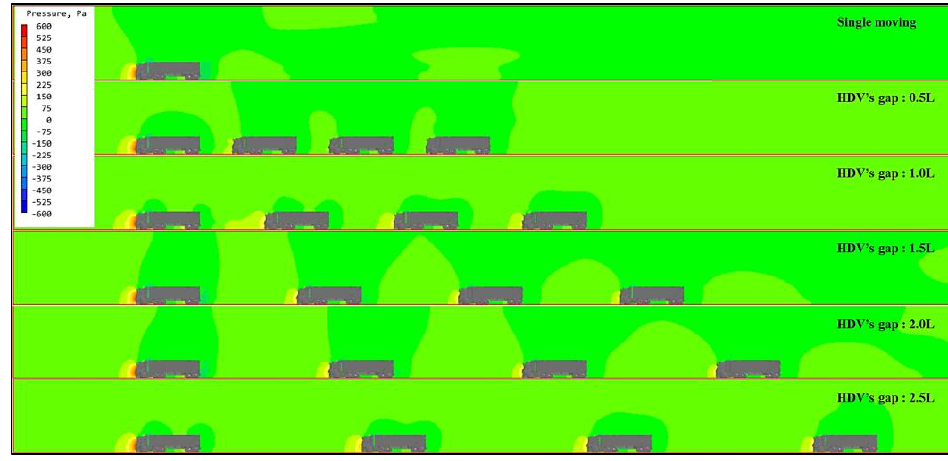
Figure 6. Comparison of the static pressure distribution with the change in the gap at 100 km/h.